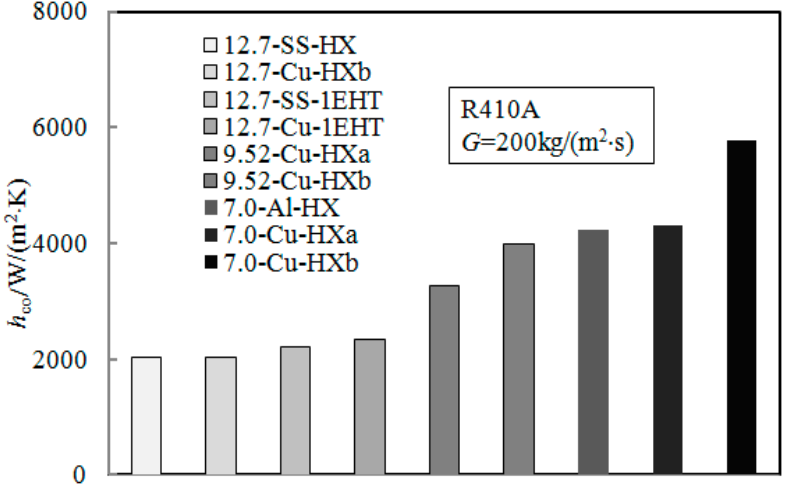
Figure 11. Effect of tube diameter on condensation HTC.